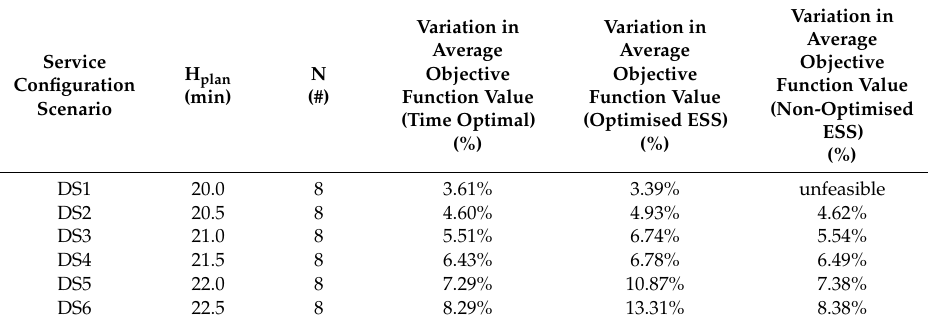
Table 9. Intervention scenario improvements in disrupted